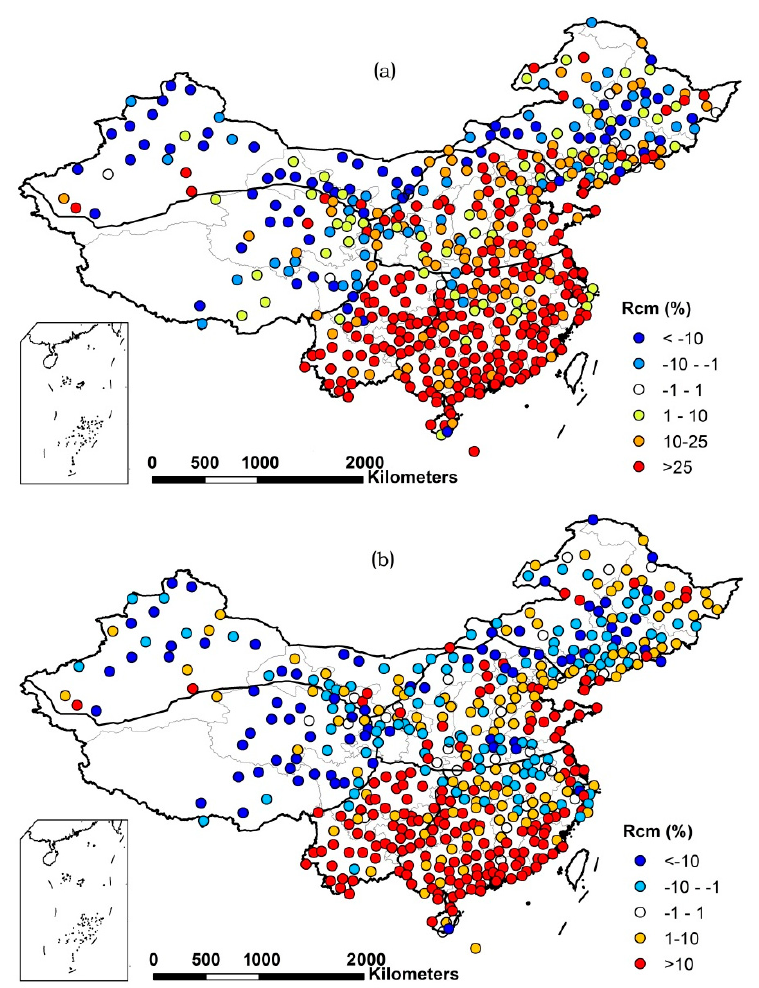
Figure6. Relativechangeratespatialdistributionsof( a )frequencyand( b Figure 6. Relative change rate spatial distributions of ( a ) frequency and ( b ) intensity of drought extremes.